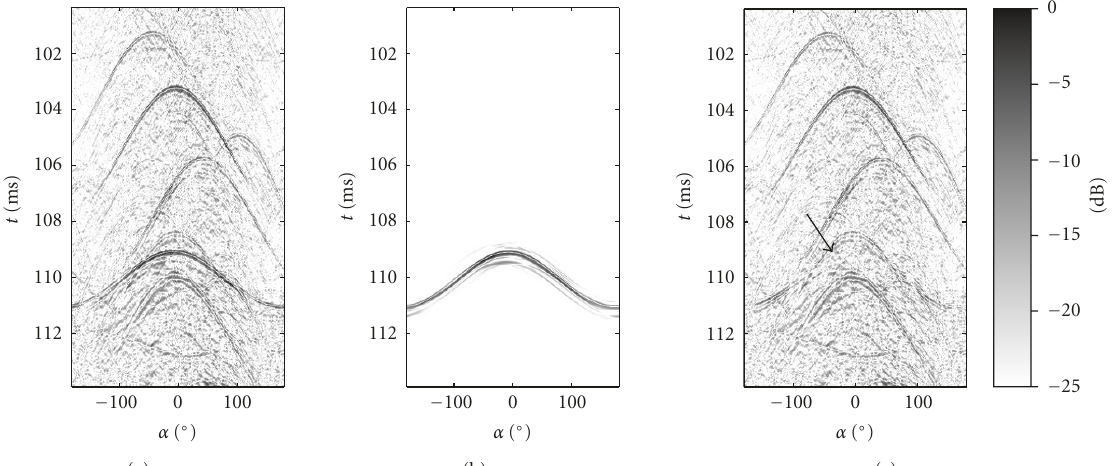
Figure 13: (a) The measured data set of Figure 4, (b) reconstruction of the response of the first-order ceiling reflection using the cylindrical harmonics decomposition method, (c) the result of subtracting (b) from